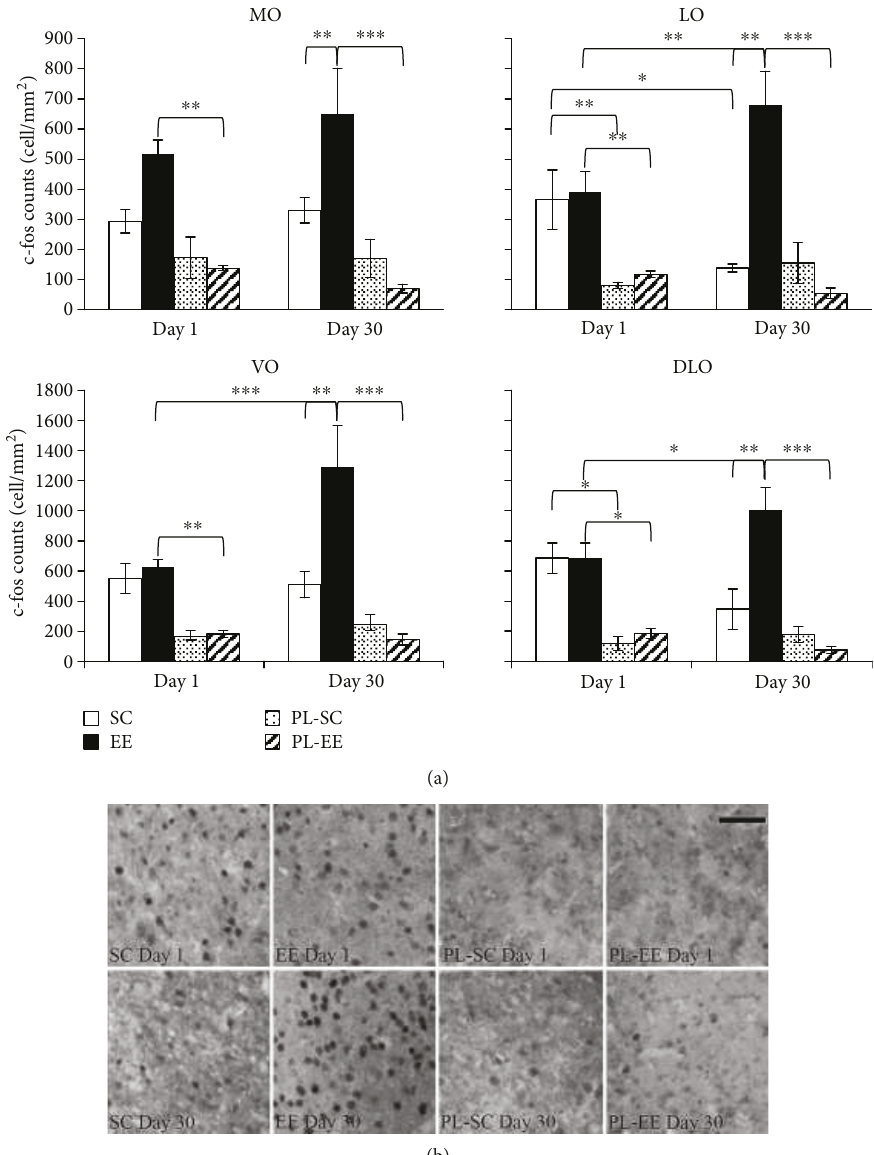
Figure 3: (a) c-fos expression in subregions of OFC for SC (open columns), EE ( fi lled columns), PL-SC (dotted columns), and PL-EE (hatched columns) mice subjected to choice phase at day 1 and day 30. MO: two-way ANOVA, factor condition ( p < 0 001 ), factor time ( p = 0 613 ), condition × time ( p = 0 530 ), post hoc analysis Holm-Sidak method. SC versus PL-SC and PL-SC versus PL-EE ( p > 0 05 ) for all retention intervals. Statistical di ff erences were found between EE versus PL-EE at day 1 ( p = 0 001 ) and day 30 ( p < 0 001 ); EE versus SC signi fi cant at day 30 ( p = 0 003 ). LO: two-way ANOVA, factor condition ( p < 0 001 ), factor time ( p = 0 688 ), condition × time ( p = 0 004 ), post hoc analysis Holm-Sidak method. PL-SC versus PL-EE ( p > 0 05 ) for all retention intervals. Statistical di ff erences were found between SC versus PL-SC at day 1 ( p = 0 004 ); EE versus PL-EE at day 1 ( p = 0 001 ) and day 30 ( p < 0 001 ); EE versus SC signi fi cant at day 30 ( p < 0 001 ). Statistical di ff erences within group were found between day 1 and day 30 for SC group ( p = 0 018 ) and for EE group ( p = 0 004 ). VO: two-way ANOVA, factor condition ( p < 0 001 ), factor time ( p = 0 054 ), condition × time ( p = 0 015 ), post hoc analysis Holm-Sidak method. SC versus PL-SC and PL-SC versus PL-EE ( p > 0 05 ) for all retention intervals. Statistical di ff erences were found between EE versus PL-EE at day 1 ( p = 0 001 ) and day 30 ( p < 0 001 ); EE versus SC signi fi cant at day 30 ( p < 0 001 ). Statistical di ff erences within EE group were found between day 1 and day 30 ( p < 0 001 ). DLO: two-way ANOVA, factor condition ( p < 0 001 ), factor time ( p = 0 913 ), condition × time ( p = 0 059 ), post hoc analysis Holm-Sidak method. PL-SC versus PL-EE ( p > 0 05 ) for all retention intervals. Statistical di ff erences were found between SC versus PL-SC at day 1 ( p = 0 003 ); EE versus PL-EE at day 1 ( p = 0 002 ) and day 30 ( p < 0 001 ); EE versus SC signi fi cant at day 30 ( p < 0 001 ). Statistical di ff erences within EE group were found between day 1 and day 30 ( p = 0 035 ). ∗ p < 0 05 ; ∗∗ p < 0 01 ; ∗∗∗ p < 0 001 ; error bars =SEM. (b) Representative panel of c-fos protein expression in DLO for SC, EE, PL-SC, and PL-EE mice, following recall at day 1 and day 30; scale bar: 50 μ